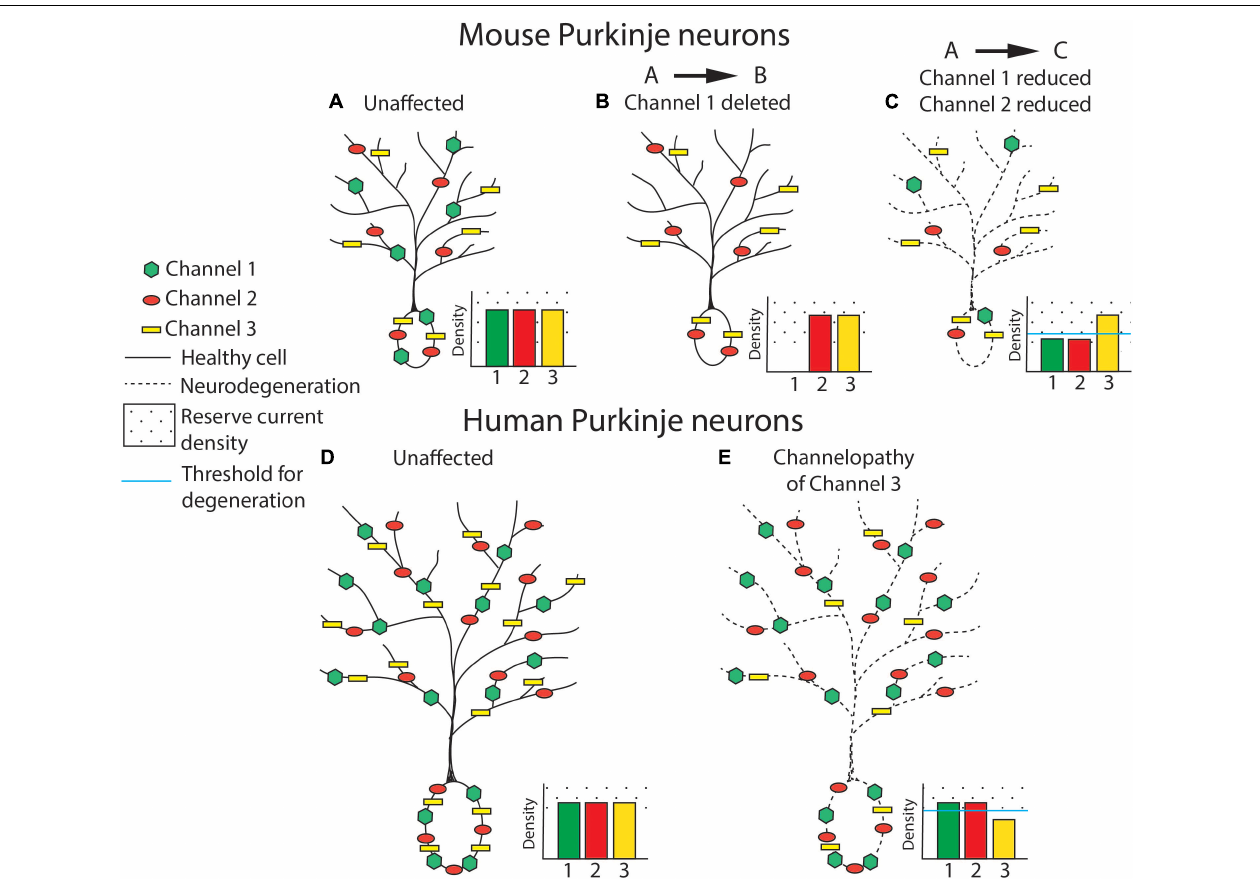
FIGURE 1 | Ion channel loss differentially influences cerebellar neurodegeneration in mice and humans. Ion channel density is represented in cerebellar Purkinje neurons from mouse (A–C) and human (D,E) . In this basic model, ion channel types are hypothesized to be relatively equivalent for their influence on neurodegeneration and are therefore represented generically as Channel 1 (green hexagon), Channel 2 (red circle), and Channel 3 (yellow rectangle). For each panel, density of expression for each ion channel is represented in a bar plot on the inset of each neuron, with the threshold of channel loss needed to produce neurodegeneration represented by a solid blue line and ion channel “reserve density” noted with a dotted background. Note that the level of reserve ion channel density to produce channel dysfunction is higher in mice for each channel, and that the baseline ion channel density is similar in human and mouse neurons. (A) An unaffected wild-type mouse neuron is represented with normal expression of channels 1, 2, and 3. (B) Full knockout of an individual ion channel (channel 1) produces no Purkinje neuron degeneration in mice, possibly due to increased function of overlapping or compensatory ion channels. (C) Partial reduction of multiple ion channels within the same excitability pathway, as has been observed in mouse models of spinocerebellar ataxia (SCA), is sufficient to produce Purkinje neuron atrophy and neurodegeneration despite each individual channel remaining within a “reserve” level of expression. Degeneration is represented as a cell membrane with a dashed line. (D) An unaffected, normal human neuron is represented with normal expression of channels 1, 2, and 3. The density of ion channels is the same as in mouse neurons in spite of a considerable increase in cell size. (E) In humans, haploinsufficiency of a single ion channel is sufficient to induce clinical symptoms and Purkinje neuron degeneration. Degeneration is represented as a dashed cell